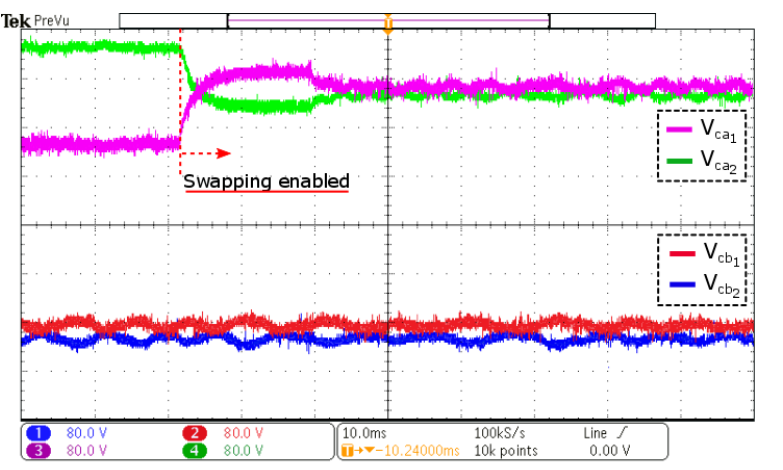
Figure 24. Experimental waveform of the balanced DC-link capacitor voltage tracing channels 1, 2, 3, 4 (80 V/div).